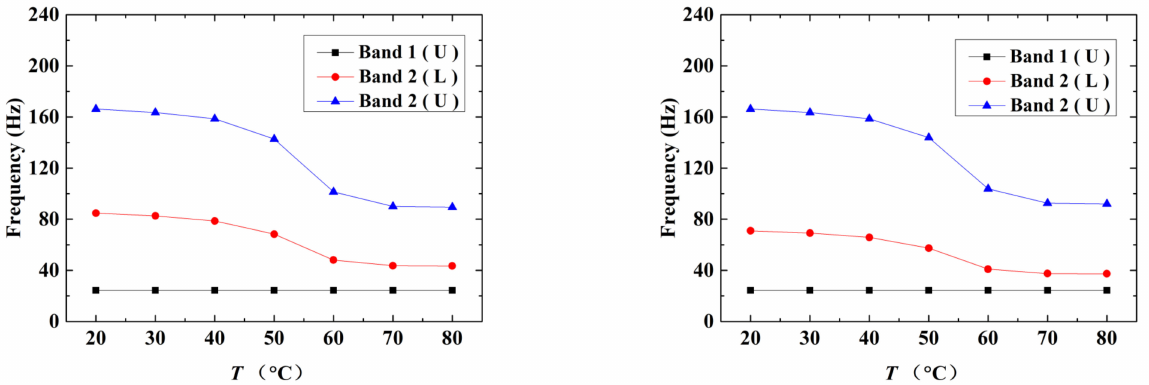
Figure 9. The influence of temperature T on band gap: ( a ) Euler beam; ( b ) Timoshenko beam.